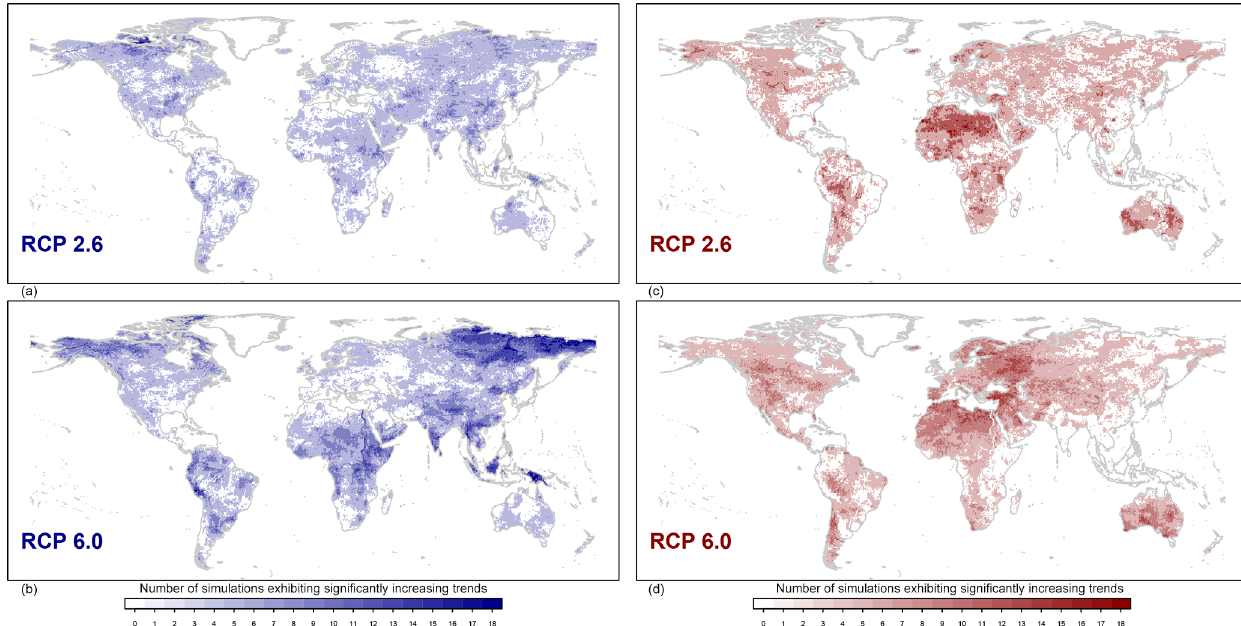
Figure 5. Number of simulations showing statistically significant trends at the 10% level at each grid cell. Panels (a) and (b) show results for the assessment of increasing trends, while (c) and (d) show results for significant decreasing trends. (a, c) Results of GCMRCP2.6 simulations; (b, d) results of GCMRCP6.0